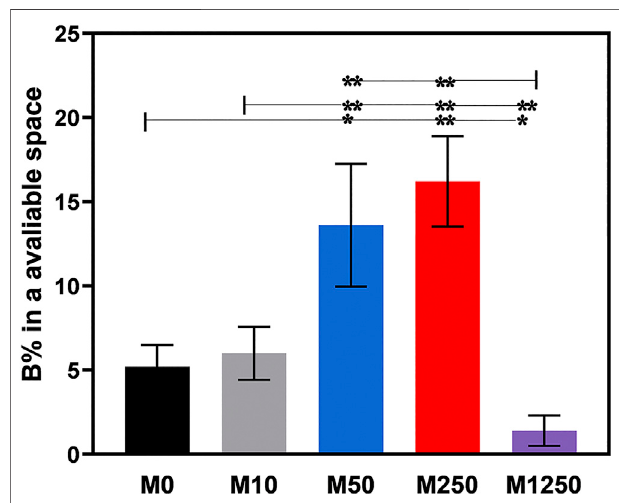
FIGURE 6 | Bone formation in the available space (%) of samples harvested from dogs (statistically signi fi cant differences are marked by * p < 0.05, ** p <